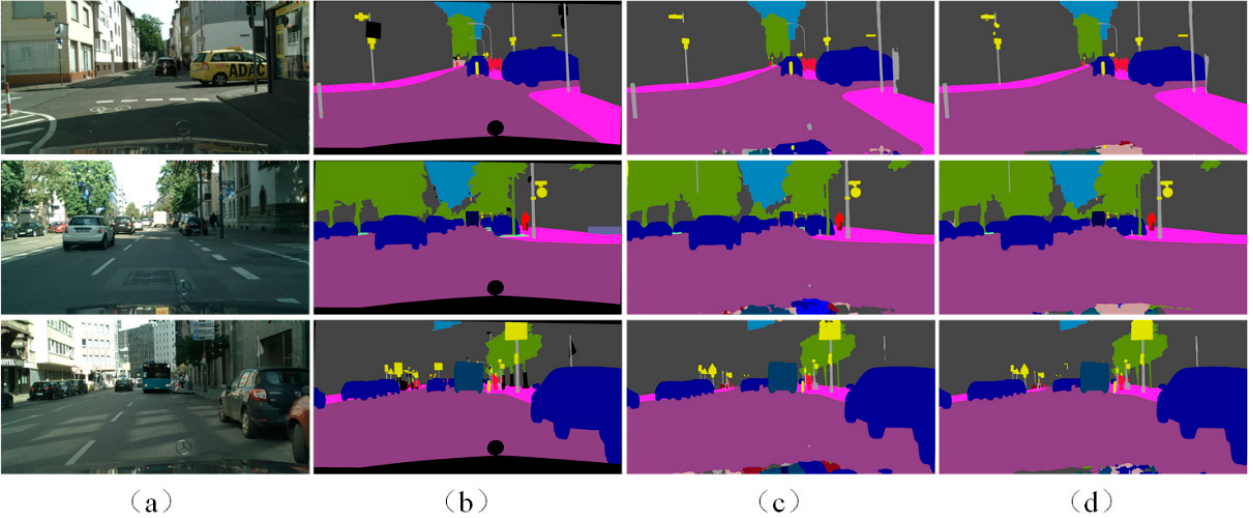
Figure 6. The visualization of the results of APMNet and the baseline on the Cityscapes dataset: ( a ) Inputs; ( b ) Ground Truth; ( a ) BiSeNet results; ( d ) APMNet results. ( a ) Inputs; ( b ) Ground Truth; ( a ) BiSeNet results; ( d ) APMNet